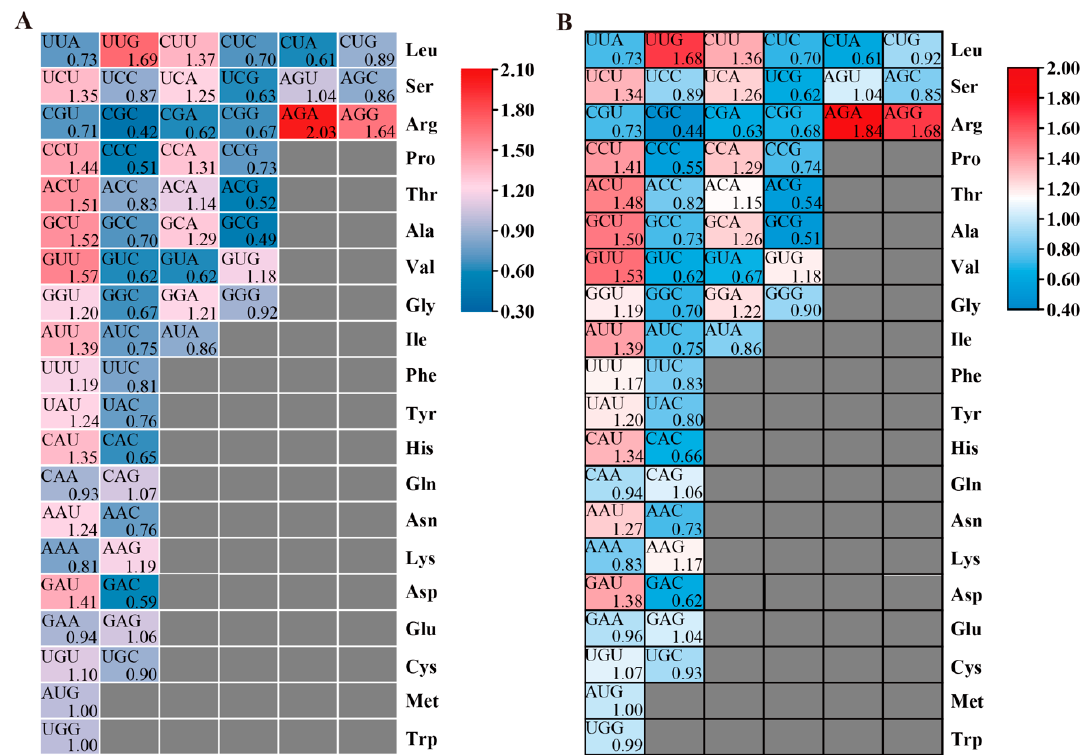
Figure 5. Codon parameter analysis of the PP2C genes in strawberry. Note: “A3s, G3s, C3s, and T3s” refer to the synonymous codon corresponding base frequency on the third; “CAI” refers to the codon adaptation index; “CBI” refers to the codon bias index; “FOP” refers to the frequency of optimal codons; “ENc” refers to the effective number of codon; “GC3s” refers to the amount of the third codon (G+C); “GC” refers to the count of genes (G+C). ( A ) Codon parameter analysis of FvPP2Cs . ( B ) Codon parameter analysis of FaPP2Cs .